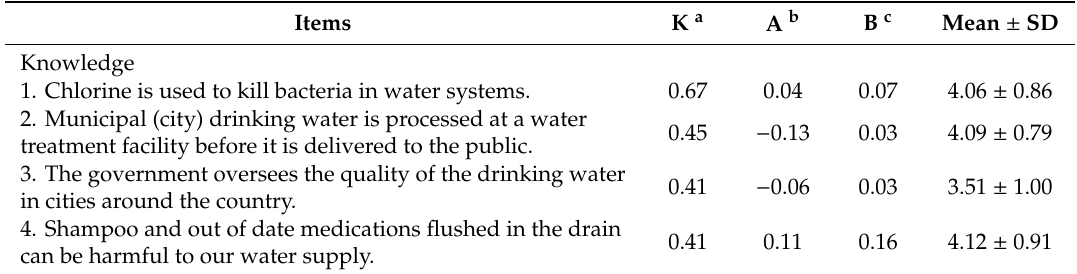
Table 6. Exploratory factor analysis results for the Water